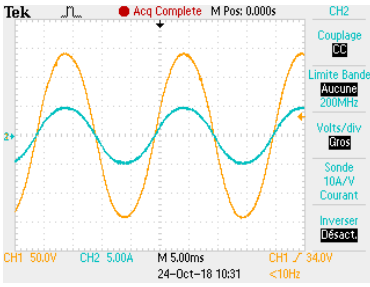
Figure 9. Input voltage at 90 V and load at 30 Ω . Experimental waveforms of v o (CH1: Time (5 ms/div), v o (50 V/div)) and I o (CH2: Time (5 ms/div), I o (5 A/div)).